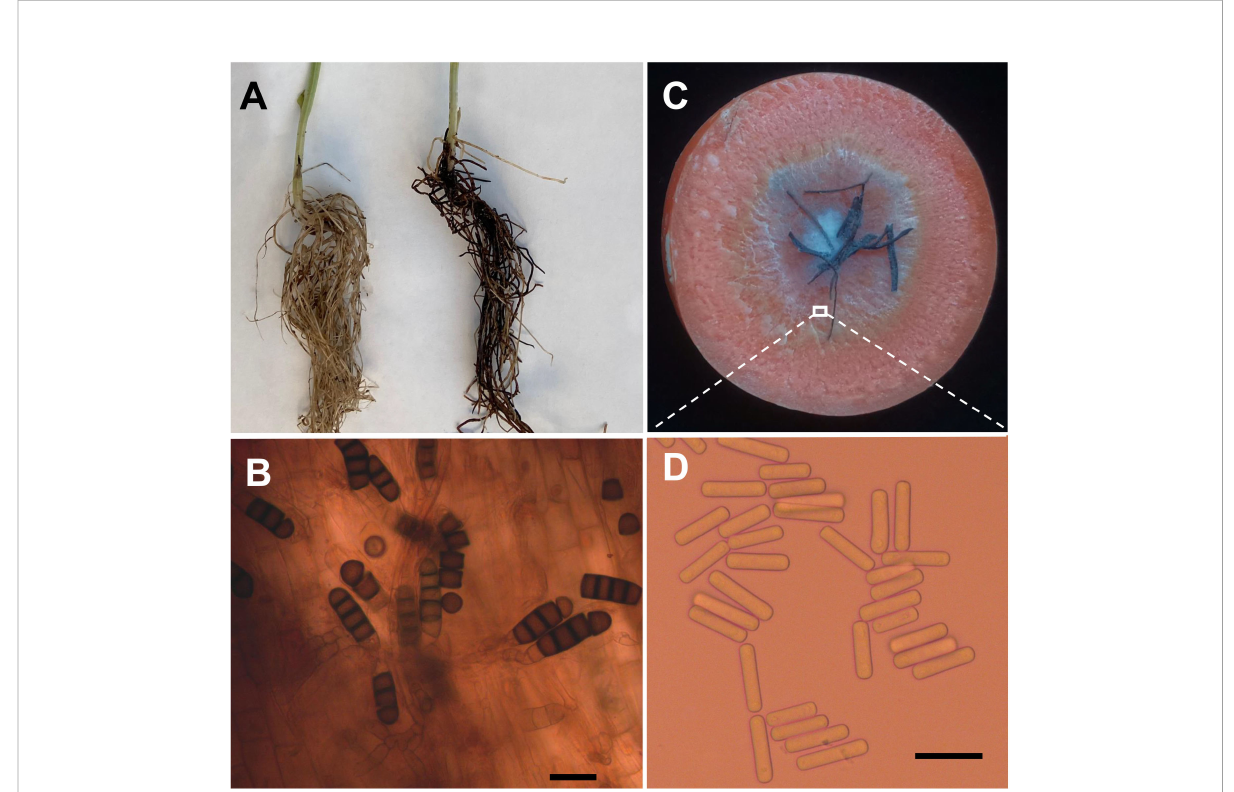
FIGURE 1 Bioassay of infected soils and isolation of pathogen causing black root on faba bean. (A) Seedlings of faba bean from control (left) and infected soils (right). (B) Chlamydospores of Berkeleyomyces rouxiae produced in faba bean diseased root. (C) Carrot slice infected by Berkeleyomyces rouxiae on faba bean diseased root. (D) Endoconidia of B rouxiae produced on carrot slice. (bar = 20 m